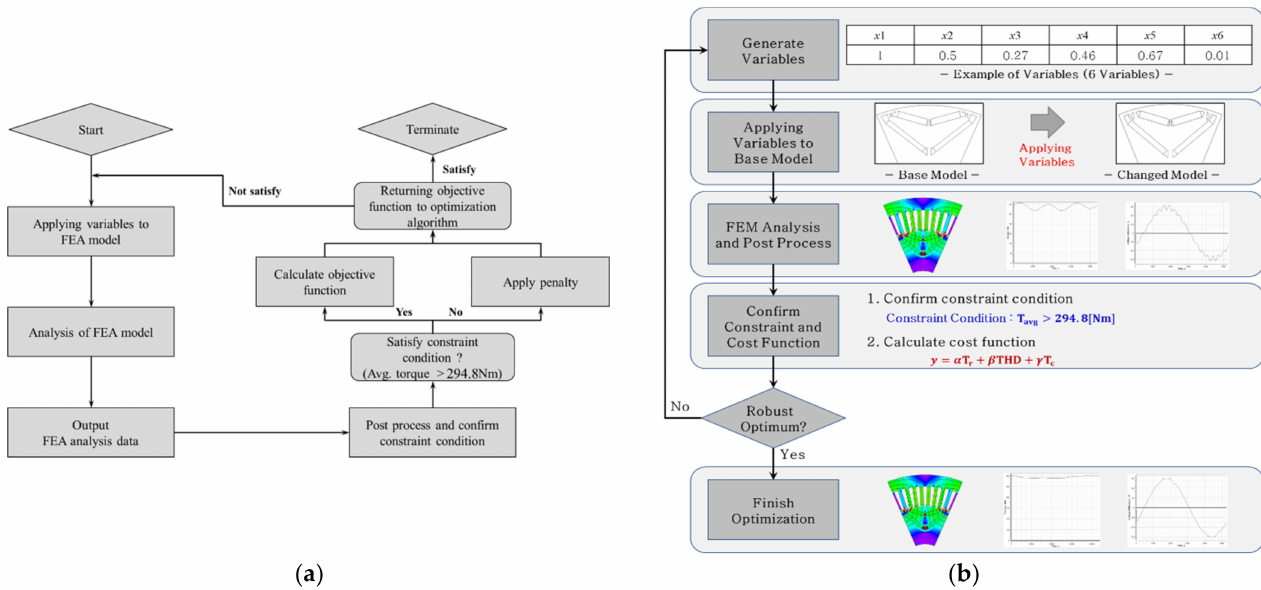
Figure 14. The flowchart of optimal design with optimization algorithm and FEM: ( a ) flow chart of optimization with optimization algorithm; ( b ) flow chart of traction motor optimization with